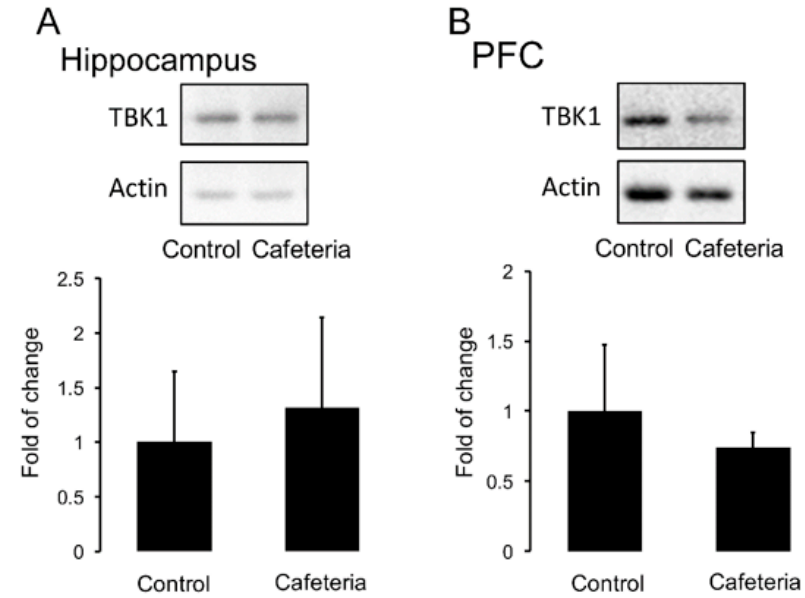
Figure 6. Effect of cafeteria diet exposure during pregnancy and lactation on TBK1 protein levels in the hippocampus. Cafeteria diet exposure during embryonic development was performed as described. Total protein of TBK1 inflammatory marker in hippocampus ( A ) and PFC ( B ) was determined by Western blot analysis as described in Materials and Methods. Graphs show mean ± SD; n = 5–8.